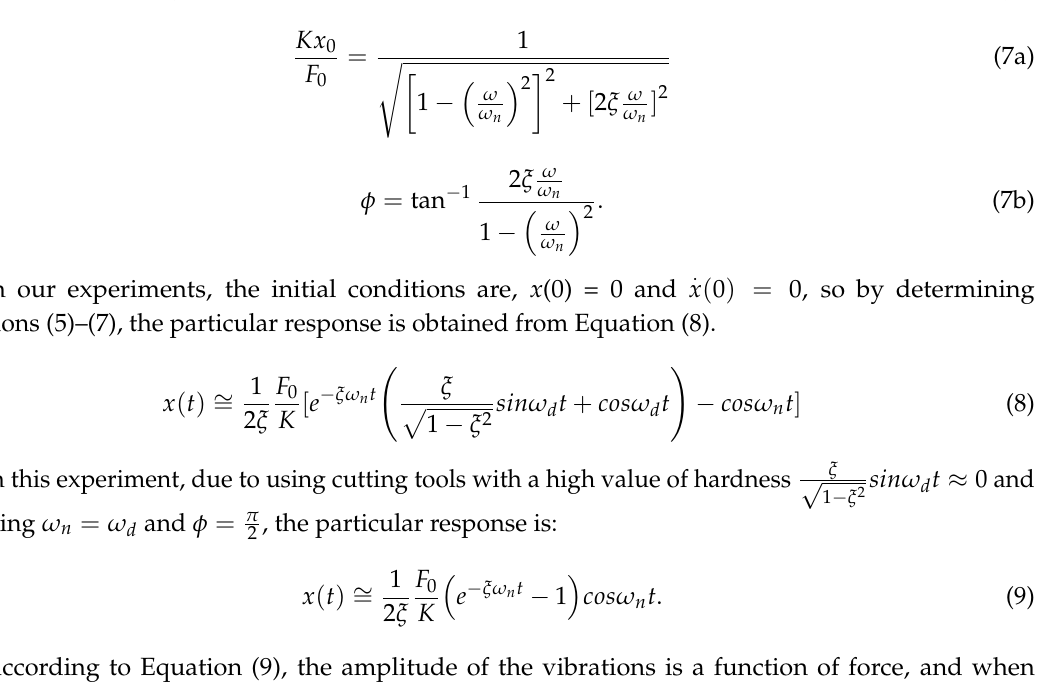
1921 Figure 9. Mass for different cutters. 15 17